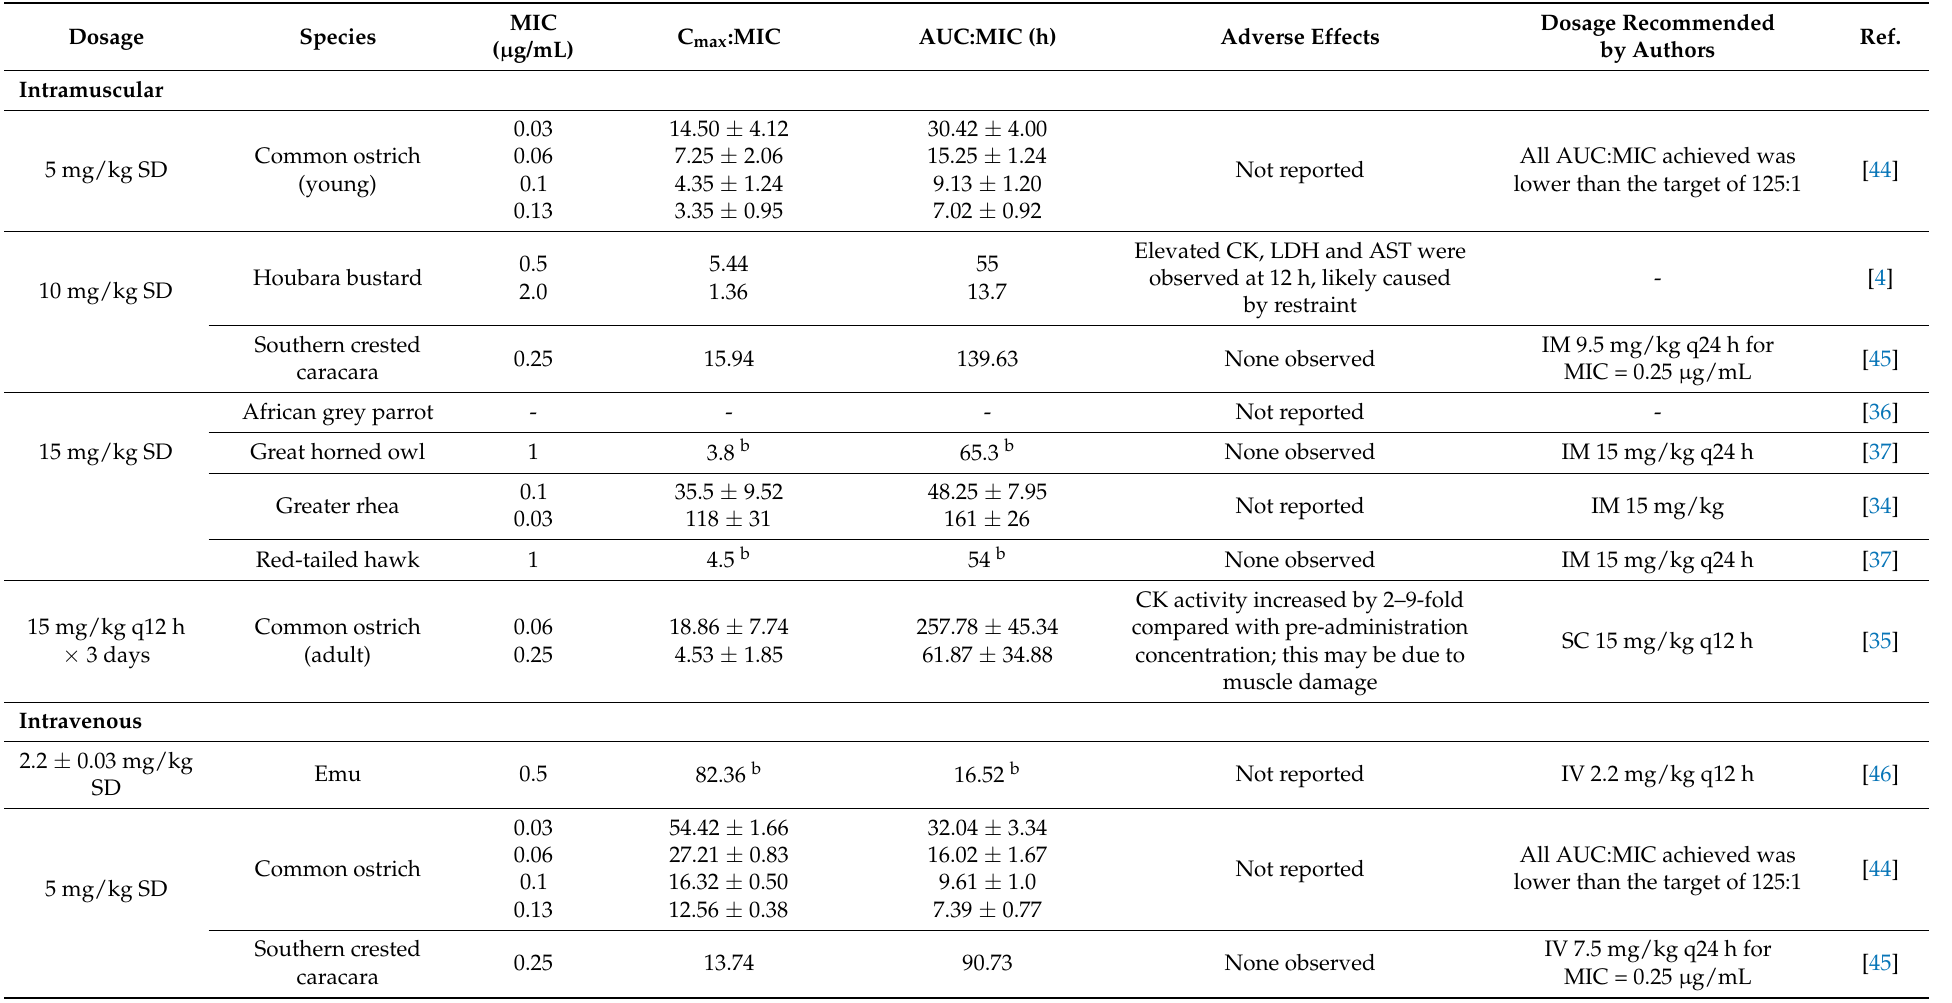
Table 2. Adverse effects, efficacy parameters, and dosage recommendations of enrofloxacin in exotic avian